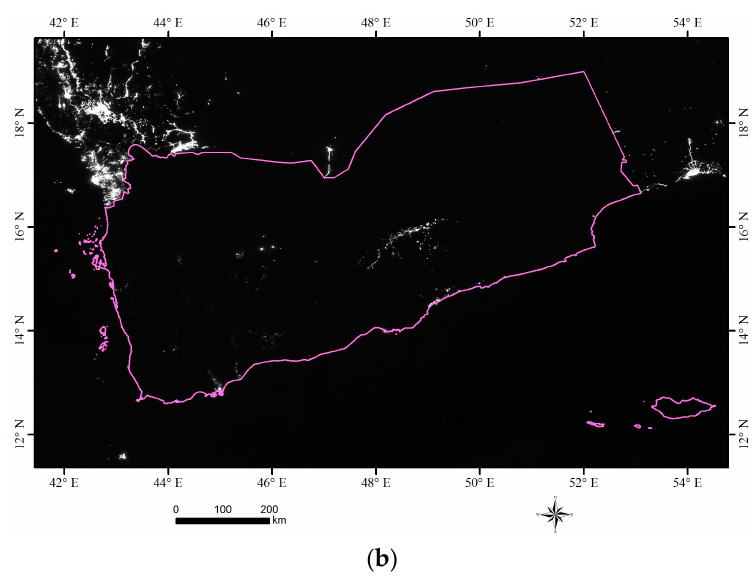
Figure 3. NPP-VIIRS nighttime light images of Yemen from ( a ) January 2014 and ( b ) December 2015.